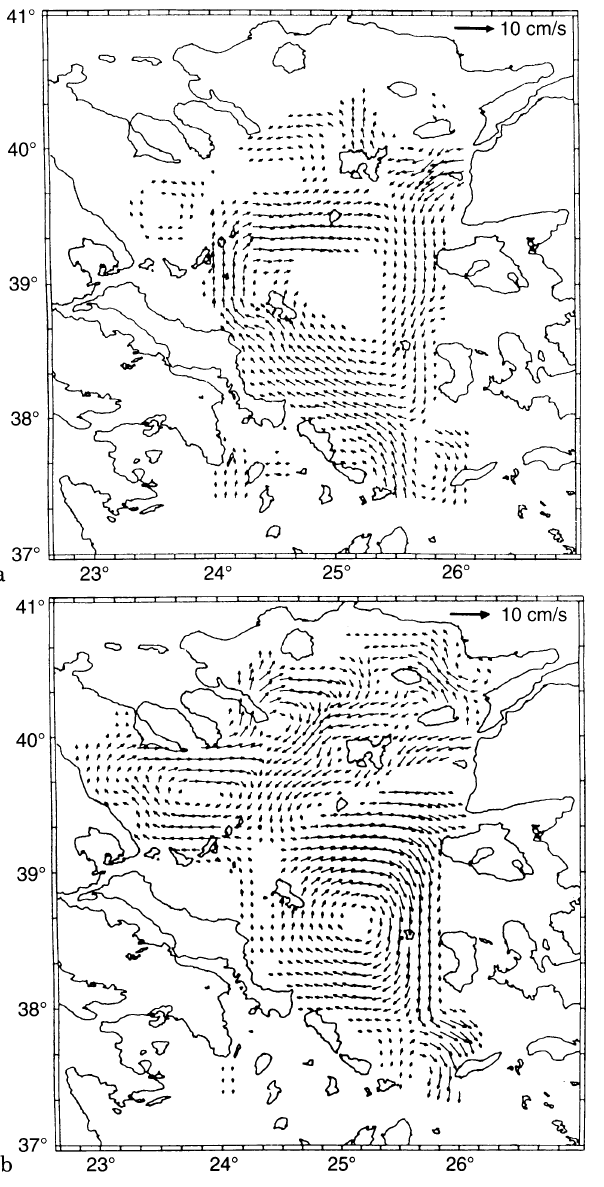
Fig. 9a,b. Simulated barotropic flow of the upper layer (40 m) of the North Aegean Sea, in the case of the one-layer 2D flow model experiment and the Hellespont Strait open with an average (8 — 12 cms (cid:126)(cid:49) ) inflow; a for 28 June 1993; b for 02 July 1993